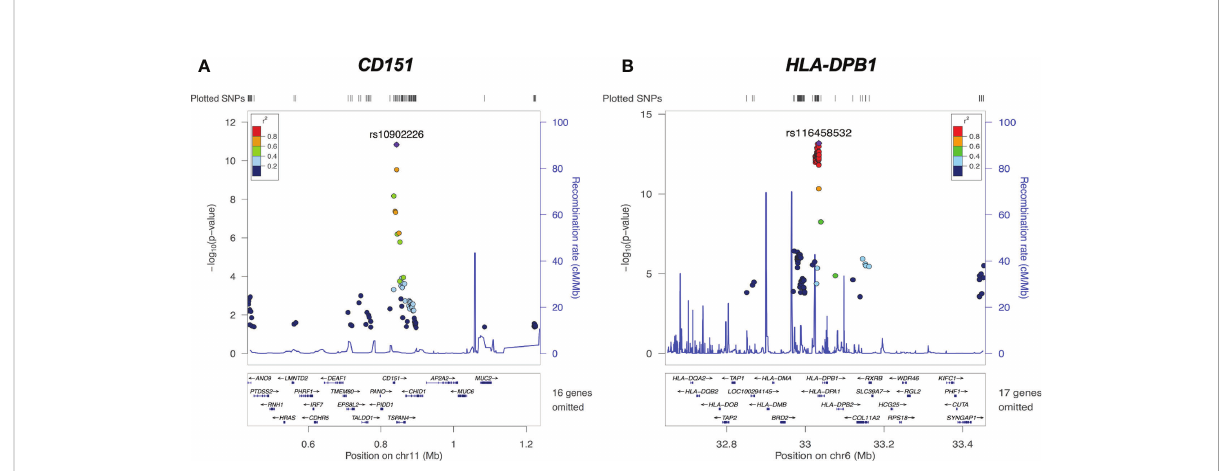
FIGURE 4 cis-eQTLs of CD151 and HLA-DPB1. (A) Regional plot on chromosome 11 CD151 locus reveals the lead cis-eQTL rs10902226 (purple diamond) is signi fi cantly associated with CD151 expression (P<10E-11). (B) Regional plot on chromosome 6 HLA-DPB1 locus reveals the lead cis-eQTL rs116458532 (purple diamond) is signi fi cantly associated with HLA-DPB1 expression (P<1.00E-13). For both graphs, each dot represents one SNP. X axis shows the physical location of the SNPs, gene names and fl anking region; Y axis indicates the − log10 value (P-value) of the respective SNP. The color for each dot represents the pairwise linkage disequilibrium r2-value against respective lead